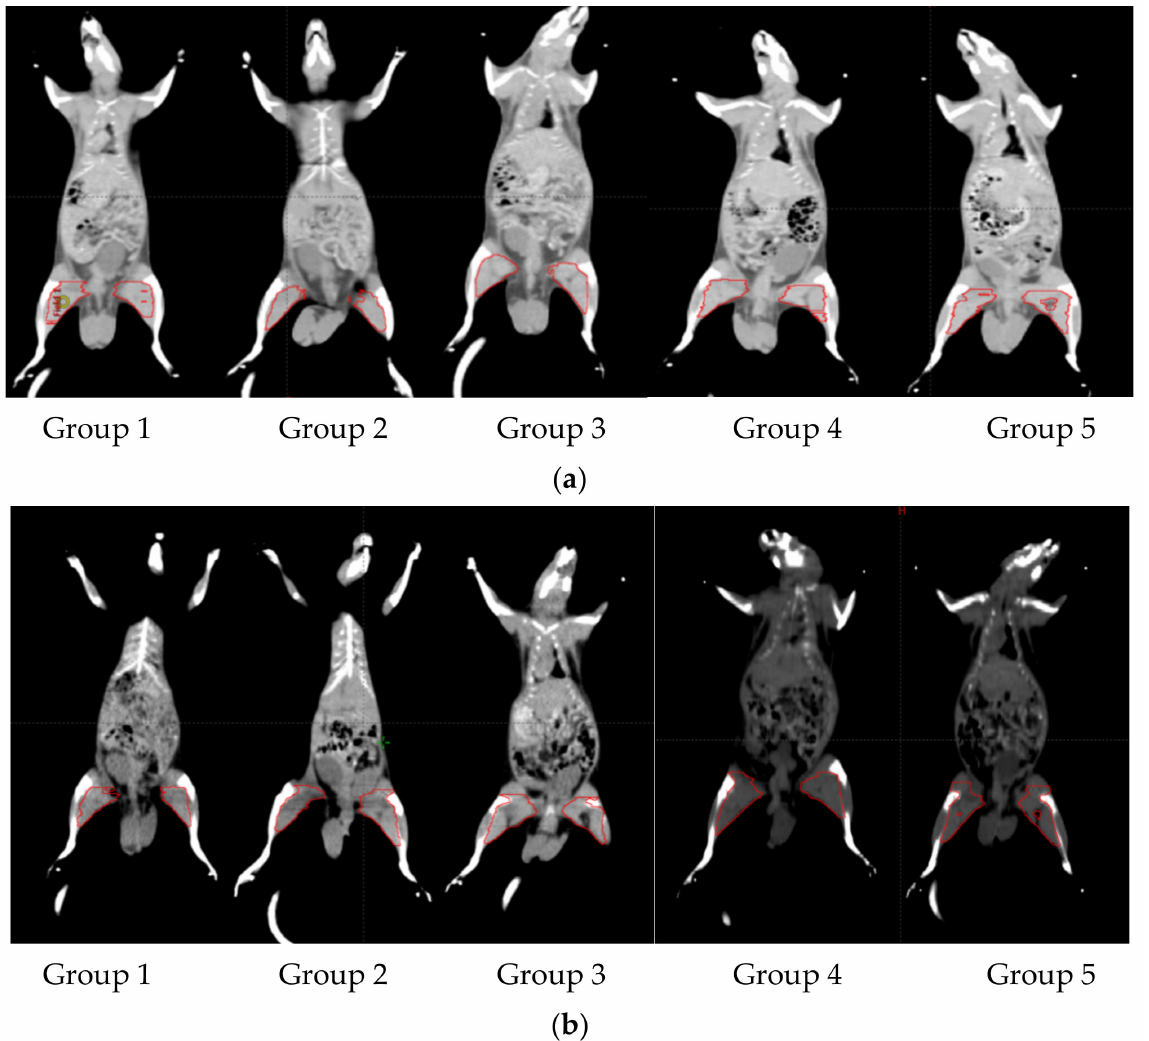
Figure 5. CT muscle scan showing first ( a ) and last intervals ( b